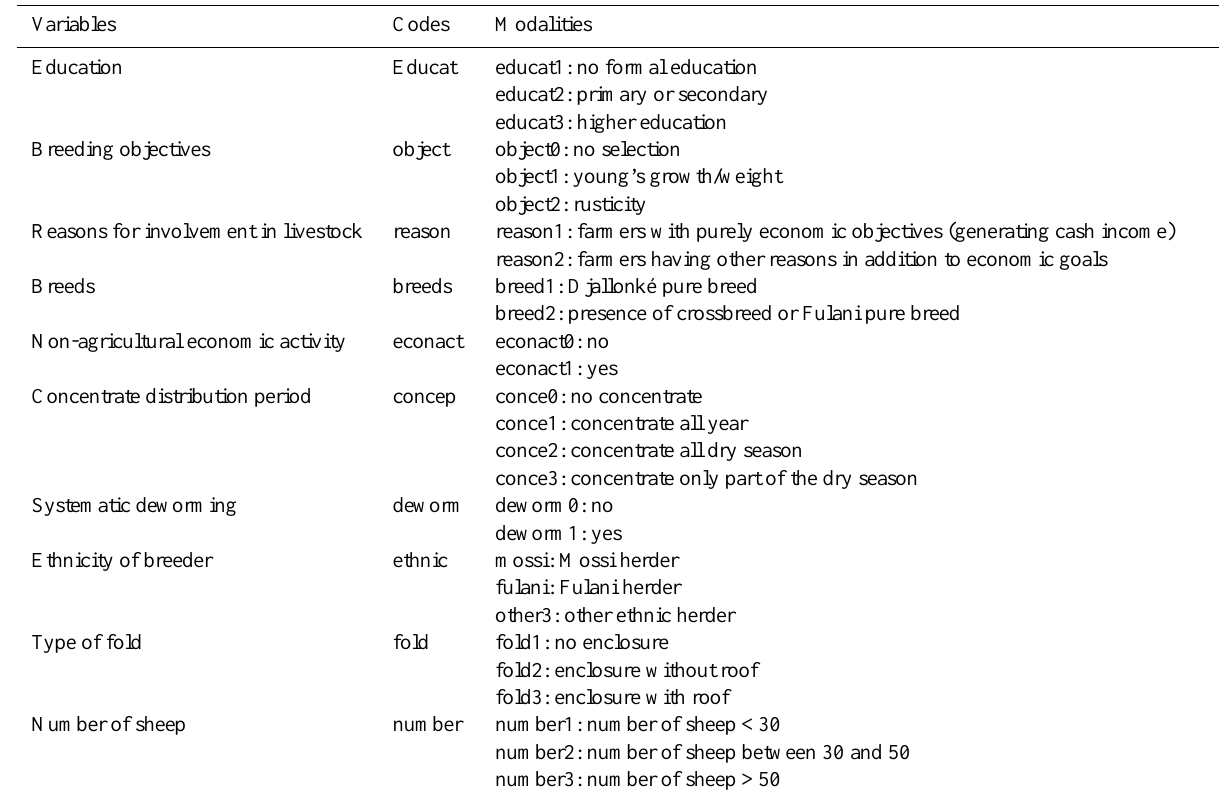
Table 1. Codes for variables and modalities used in multiple correspondence